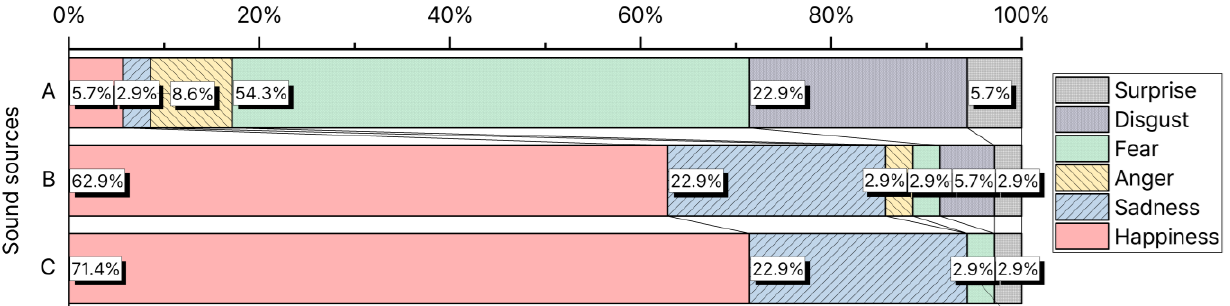
Figure 8. Results of the subjects ’ responses to the emotion questionnaire by sound sources.